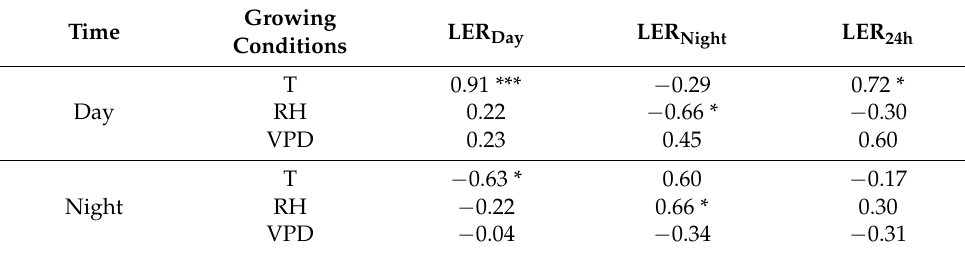
Table 4. Pearson correlation coefficients for correlations between day and night growing conditions and leaf elongations rates (LER) during day, night and 24 h, respectively, including all treatments. ***, *: significant at p < 0.001, p < 0.05, respectively. T: temperature, RH: relative air humidity, VPD: vapor pressure